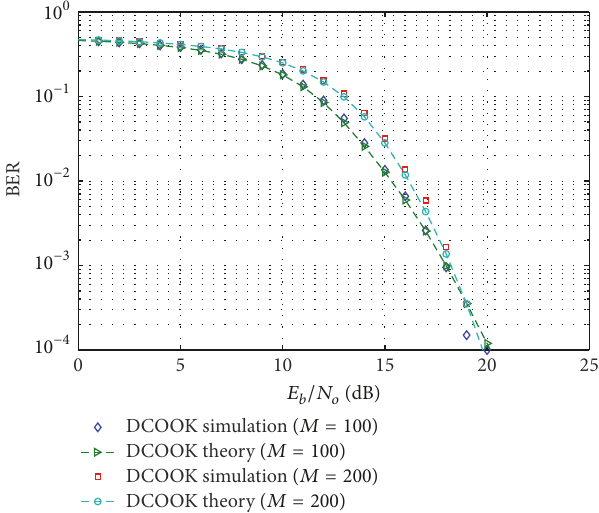
Figure 10: BER performance versus spreading factor 𝑀 .